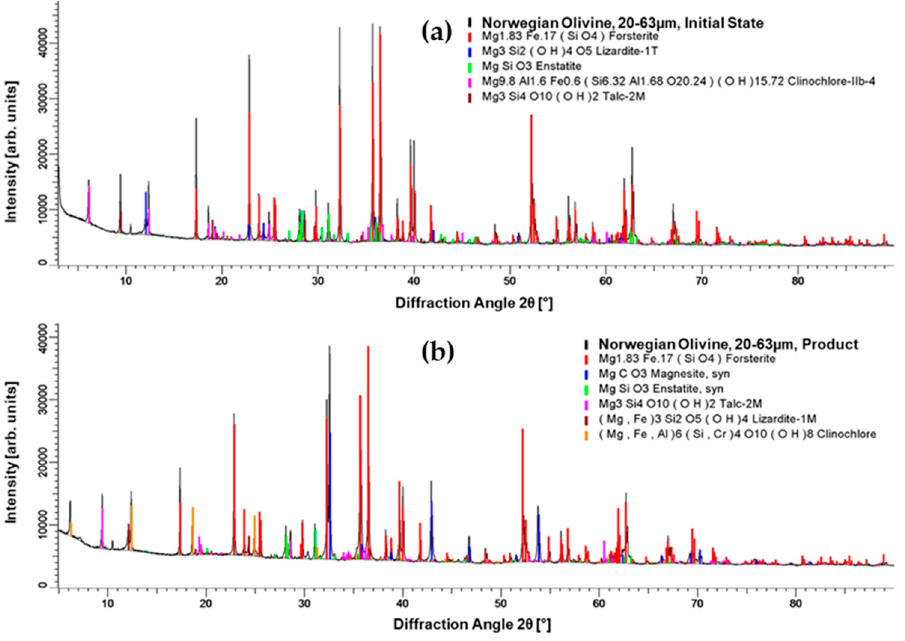
Figure 5. X-ray di ff raction (XRD) analysis of Norwegian olivine samples: ( a ) initial state and Figure 5. X-ray diffraction (XRD) analysis of Norwegian olivine samples: ( a ) initial state and ( b ) ( b ) carbonation carbonation product.